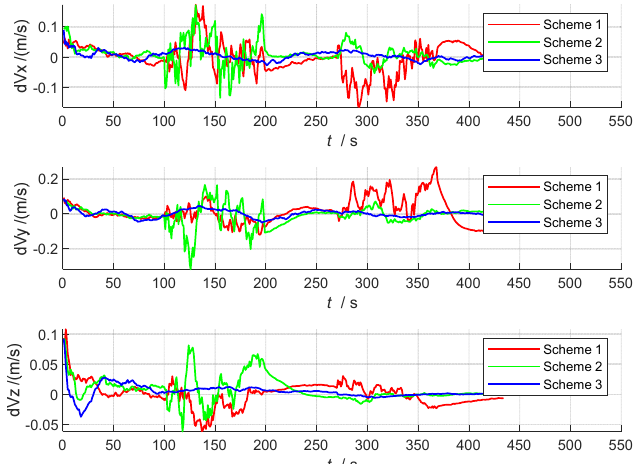
Figure 7. Speed error comparison chart.